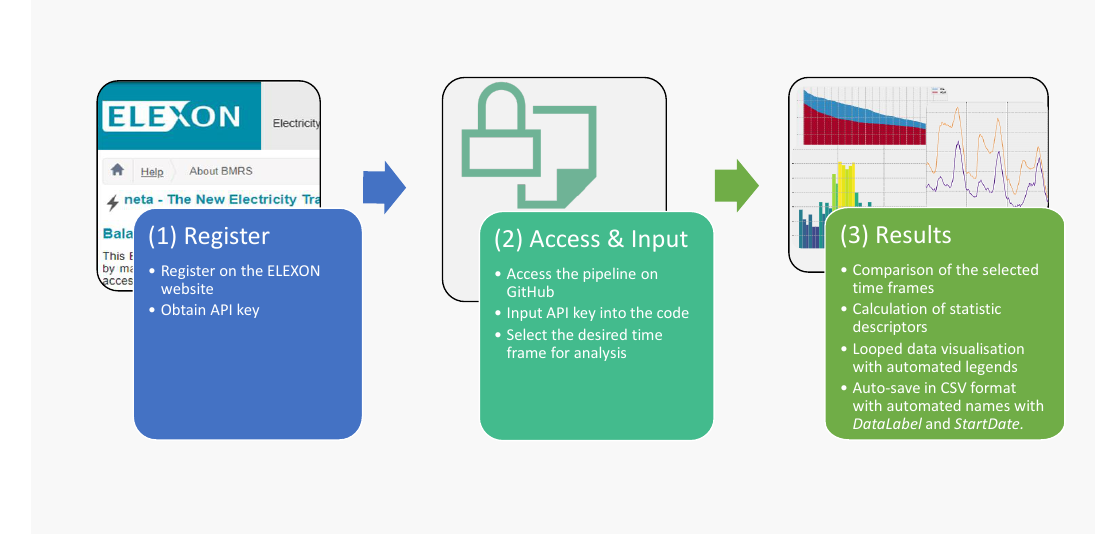
Figure 1. The flowchart displaying the steps for employing the data pipeline which are registering, accessing the code repository and producing the results in